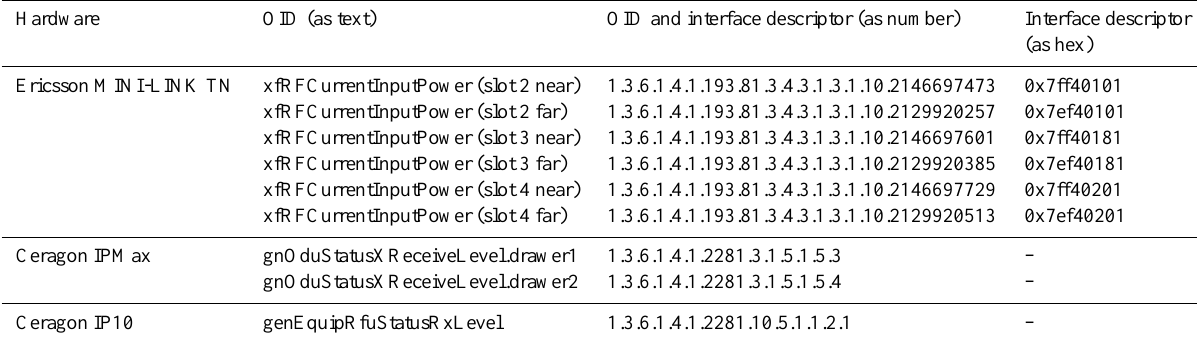
Table A1. Variations of the OIDs for requesting the current received signal level for different CML systems and, if applicable, for their subsystems. The Ericsson MINI-LINK Traffic Node (TN) uses an interface descriptor to identify the subsystems and is able to also access data from the far end of the CML. The Ceragon IPMax systems support only two subsystems in separate drawers, while the Ceragon IP10 does not support